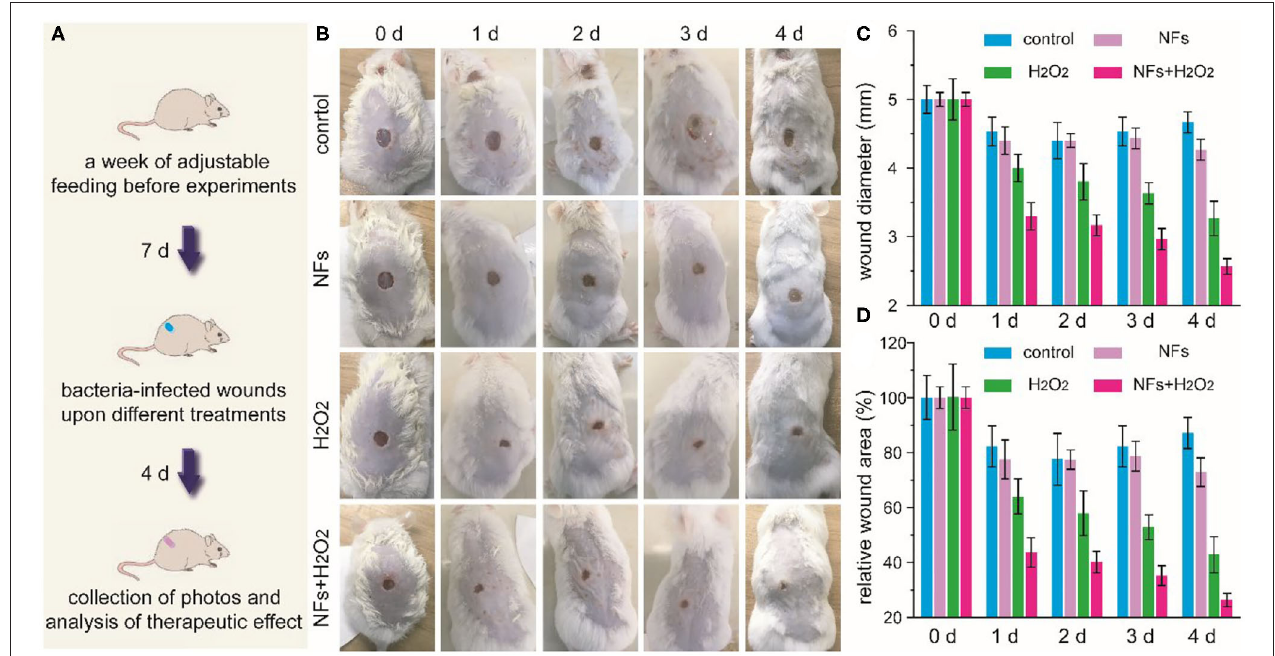
FIGURE 5 | Schematic illustration of drug-resistance S. aureus -induced infection and the following experimental design of antibacterial treatment (A) . Time-dependent photos of bacteria-infected wounds (B) , wound diameters (C) , as well as relative wound areas (D) after different treatments during the therapeutic